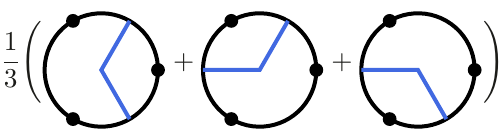
Figure 2 . A pictorial representation of h A 1 , [ A 2 , A 3 ] i . The insertions of the operators f 1 ◦ V 1 (0), f 2 ◦ V 2 (0), and f 3 ◦ V 3 (0) are represented by dots on the boundary of the disk, and the insertions of the line integrals X [ f 1 ], X [ f 2 ], and X [ f 3 ] are represented by blue